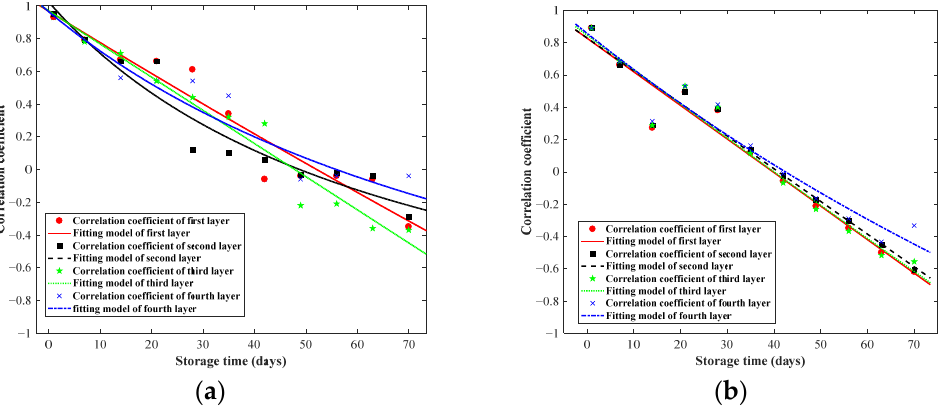
Figure 5. The model of grain temperature correlation coefficient threshold on the XOZ plane. ( a ) Fitting models of clustering results with DBSCAN. ( b ) Fitting models of clustering results with 3 σ . Table 3. Model parameters of grain temperature correlation coefficient threshold on the XOZ plane. Planes